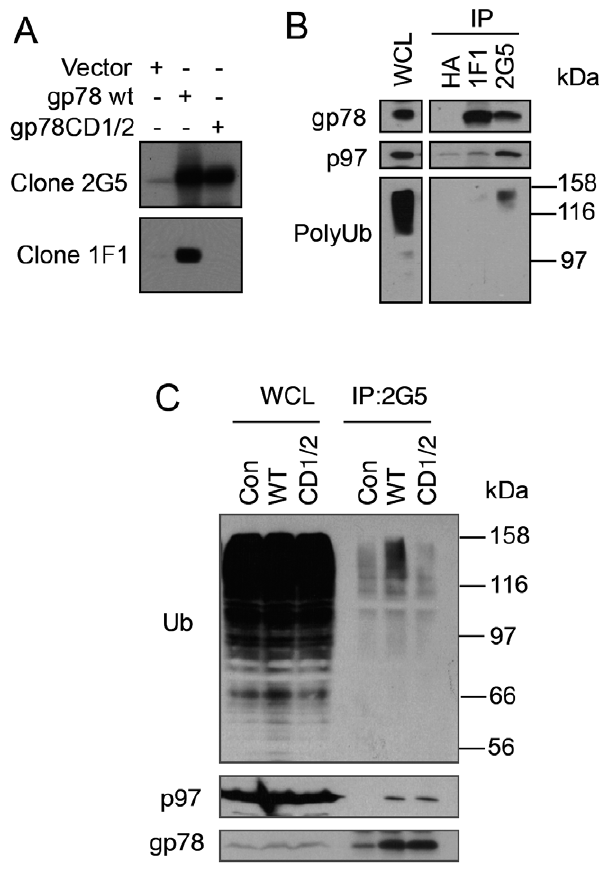
Figure 7. Anti-cue domain antibody fails to co-immunoprecip- itate p97/VCP and polyubiquitinated proteins. A. Monoclonal anti-gp78 antibody clone 1F1 does not recognize gp78CD1/2. HEK293 cells expressing wt gp78 and gp78CD1/2 were subjected to immuno- blotting with anti-gp78 antibody clone 2G5 and 1F1, respectively. B. 1F1 precipitates gp78 but not p97/VCP and polyubiquitinated proteins. gp78 was immunoprecipitated from HEK293 cell lysates with 2G5 and 1F1, respectively. Co-immunoprecipitation of p97/VCP and polyubiqui- tinated proteins was examined by immunoblotting. C. gp78CD1/2 interacts with p97/VCP but not polyubiquitinated proteins. HEK293 cells transfected with wt gp78 or gp78CD1/2 was processed for immuno- precipitation with 2G5